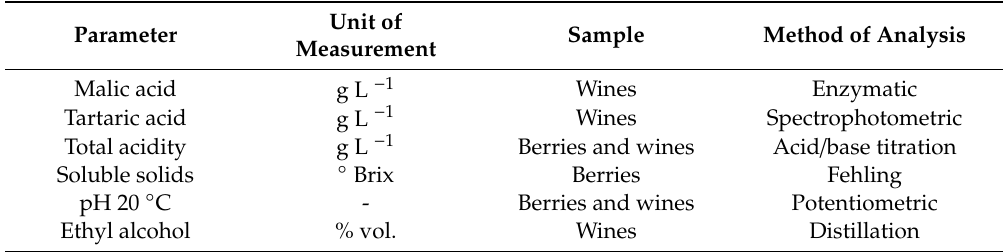
Table 2. Chemical analysis of Trebbiano d’Abruzzo berries and wines obtained from vines treated with Italian chabasite-rich zeolitite and Italian copper chabasite-rich zeolitite (ICZ and ICZCu) towards grey mould and sour rot in 2019 in Controguerra